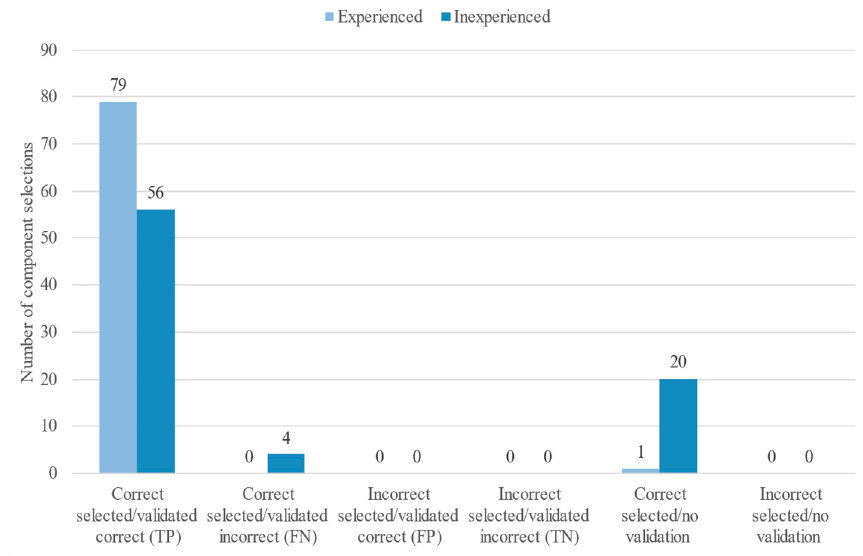
Figure 13. Component selection validation results for experienced and inexperienced